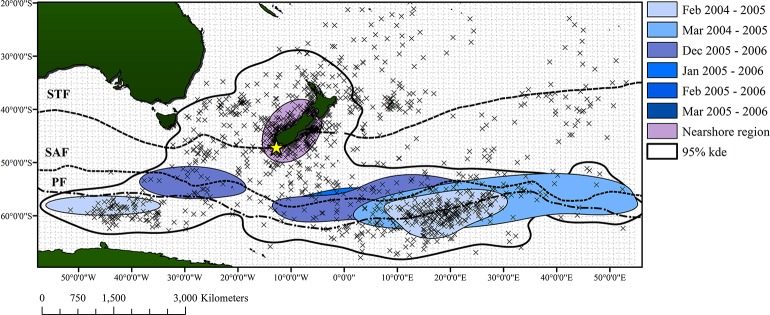
Map showing GLS data from Shaffer et al. (2006) for GLS birds tracked from Whenua Hou/Codfish Island (starred on the map) from January 2005 to March 2006.The 95% kernel density polygon for all data is represented by the largest polygon with a white background, while monthly 50% kernel densities for the offshore regions (offshore core foraging areas), and the 50% kernel density polygon for the nearshore region are represented by blue hues. The sub-Tropical front (STF), sub-Antarctic front (SAF), and Polar front (PF) are also represented on the map. The grid in the background represents the resolution of the environmental data used for modeling.